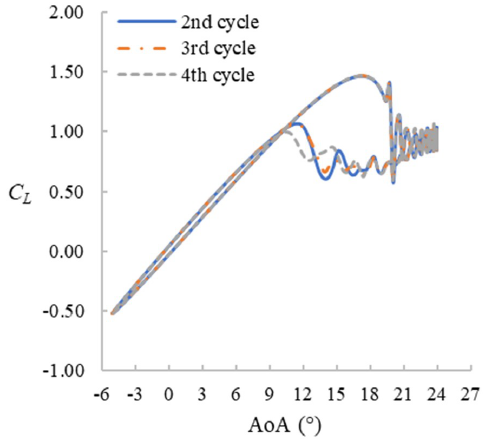
Figure 2. C L hysteresis loop for the second, third, and fourth cycles. f = 0.01, maximum AoA = 24°.